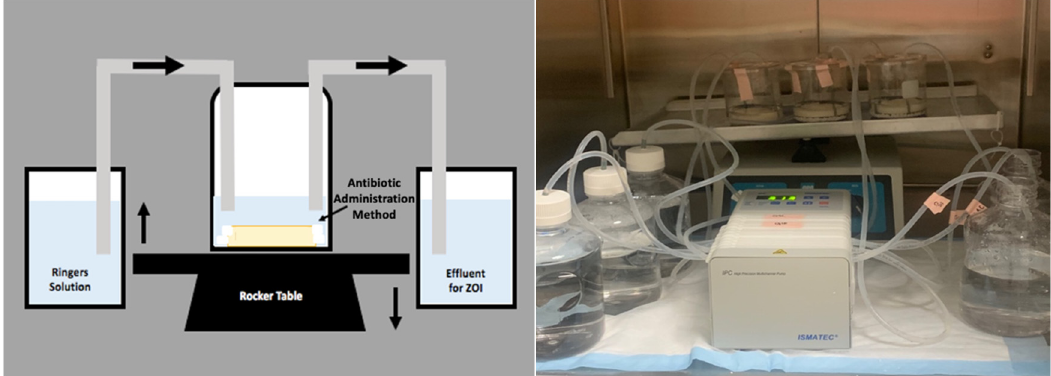
Figure 7. Schematic and real image of the in vitro draining knee reactor system. The system was placed onto a VSR-50 laboratory platform rocker at a frequency of 5 RPM. Ringers solution was pumped into and out of the reactor vessel at flow rates derived from post-operative surgical drainage rates.